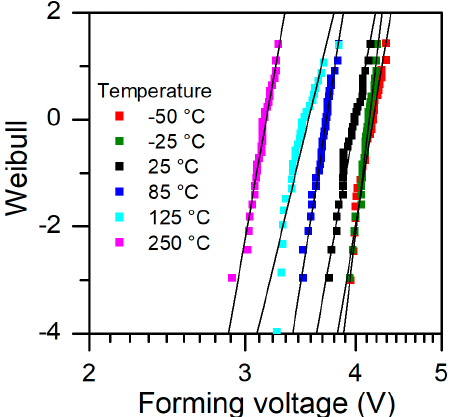
Figure 4. Forming voltage statistics, Weibull plot at different temperatures. Table 1. Weibull distribution parameters for forming voltage of investigated RRAM devices at var- ious temperatures.